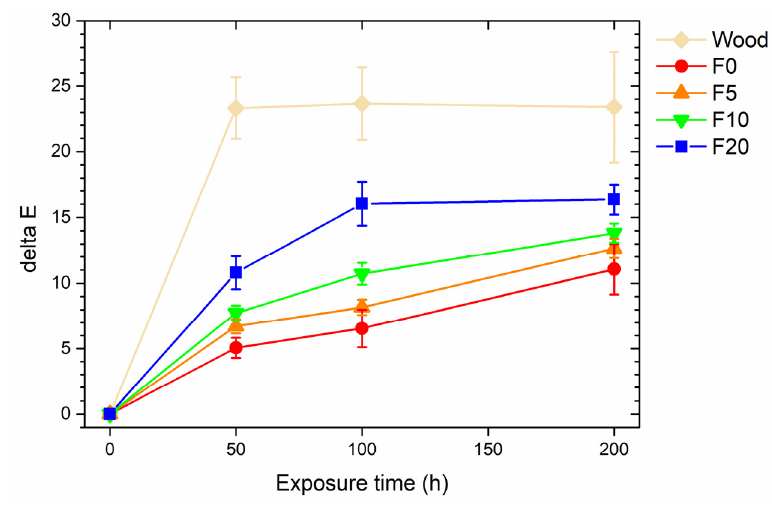
Figure 5. Color variation of the samples during UV-B exposure.